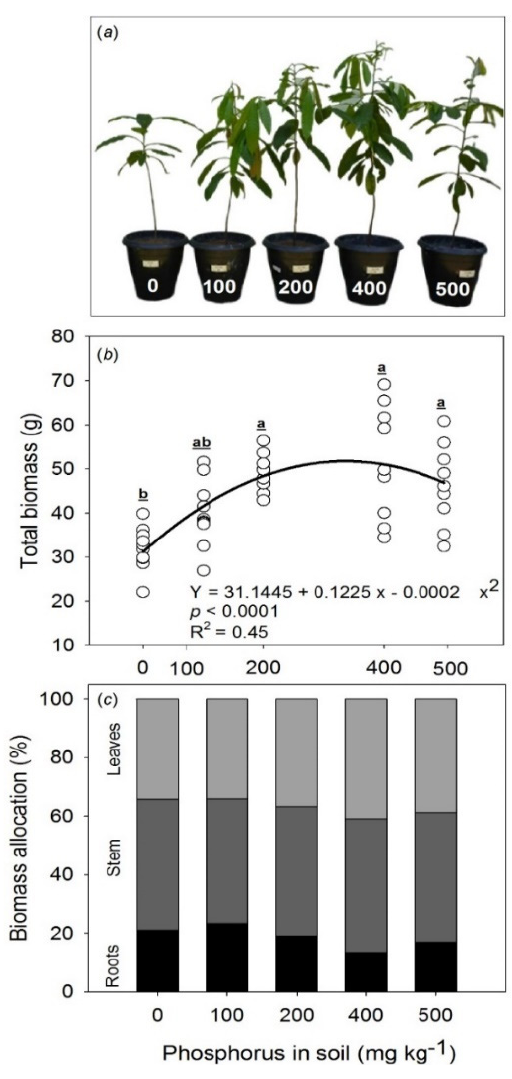
Figure 5. Influence of phosphorus soil availability on total dry biomass accumulation ( a , b ) and biomass allocation of Bertholletia excelsa with 24-month-old saplings ( c ) in P-deficient Amazon Ferralsol. Different letters indicate significant differences between the means by the Tukey test at a 0.05 probability level.